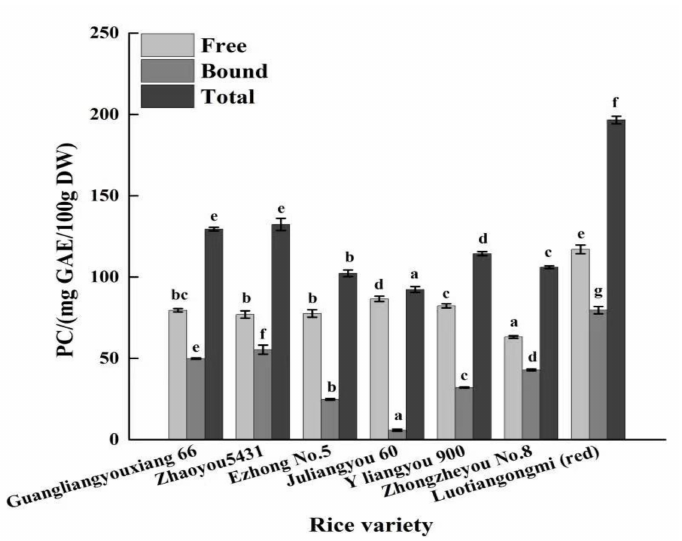
Figure 1. Free and bound PC in seven different varieties of brown rice. Results are expressed as mean ± SD. Percent contribution to total content is presented in parentheses. Different letters indicate significant differences among varieties for each fraction (free/bound/total) ( p < 0.05). DW, dry weight of sample.